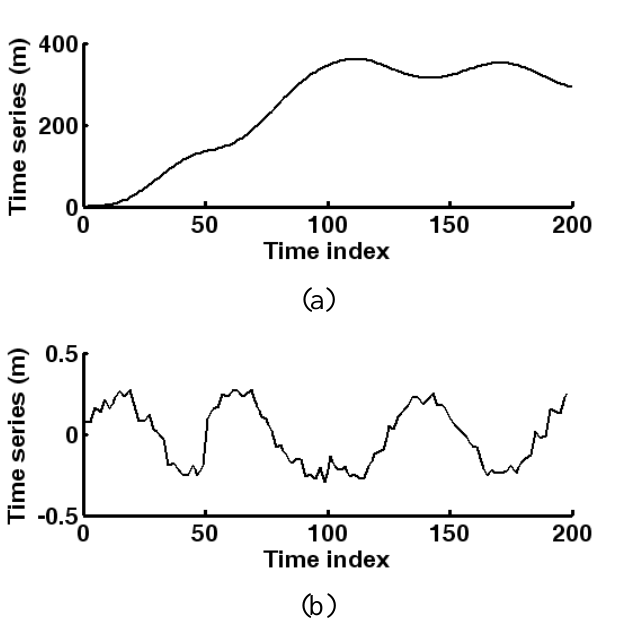
Figure 3. Simulated time series of target trajectory: (a) Before differentiation; (b) After differentiation.